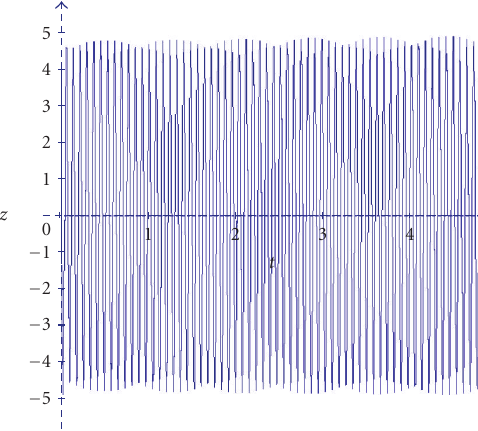
Figure 6.19 . Bounded solution of (5.2) in the point U (652 . 6,50), a 0 =